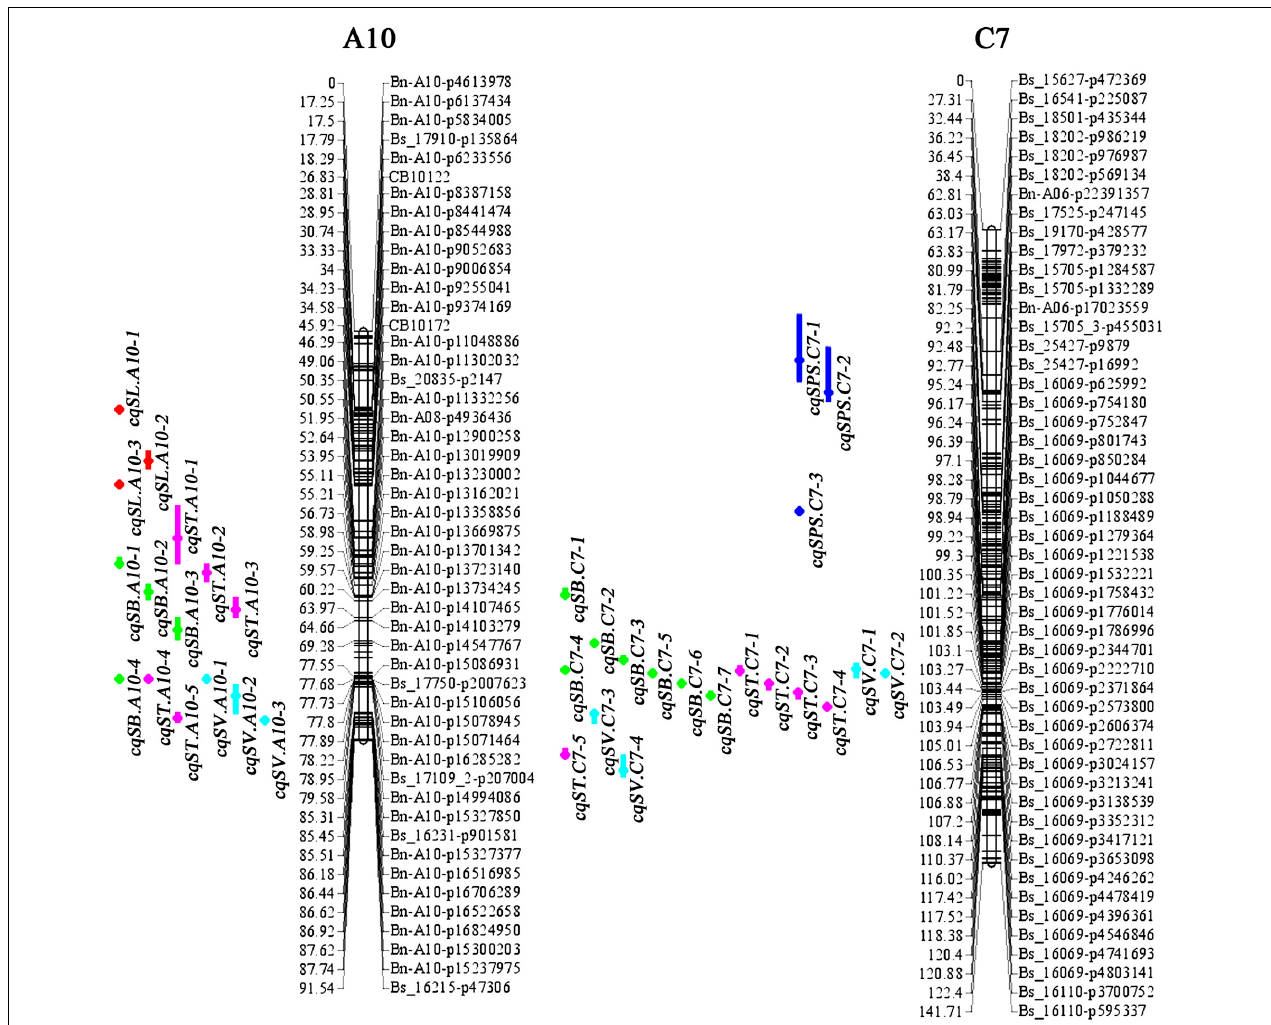
FIGURE 2 | Consensus QTL locations of silique-related traits on chromosomes A10 and C7 detected in seven different environments. Only SNPs in the confidence interval of each QTL, and the terminal two SNPs of each linkage group, are marked. The numbers listed on the left of the linkage group are distances in cM, and the locus names are on the right. Consensus QTLs for different traits are represented by different colored vertical bars: red, SL; green, SB; pink, ST; blue, SPS; turquoise,